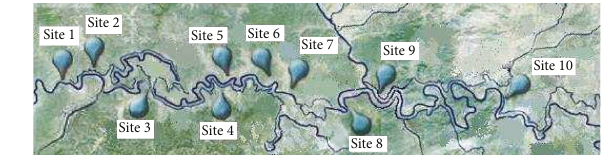
Figure 2: Site 1–Site 10 locations.